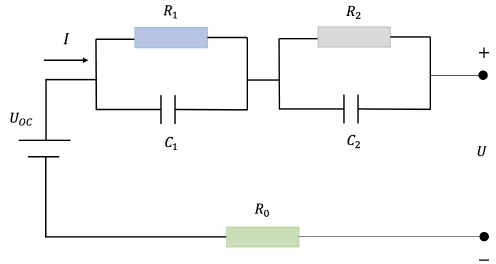
Figure 2. The structure of second-order ECM.